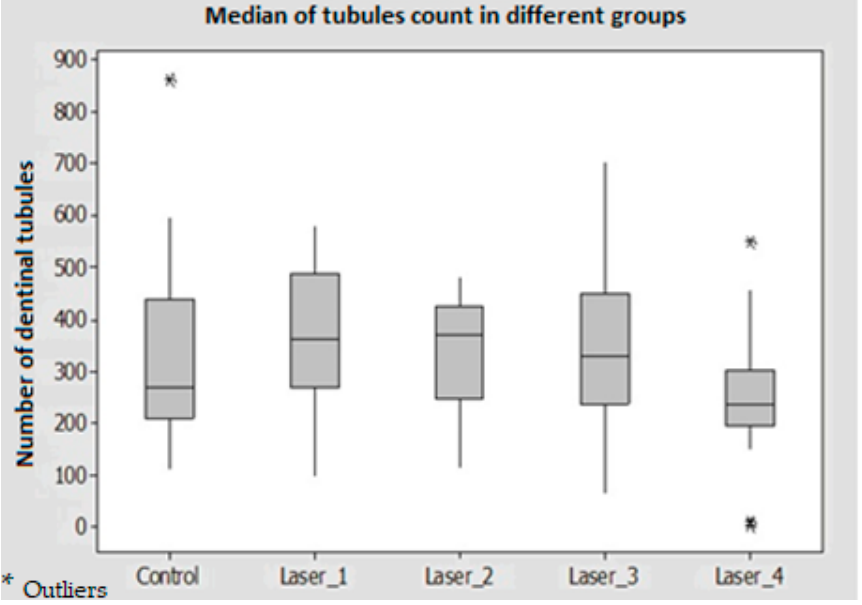
Figure 6. Comparison of exposed dentinal tubules count between the control and laser groups.